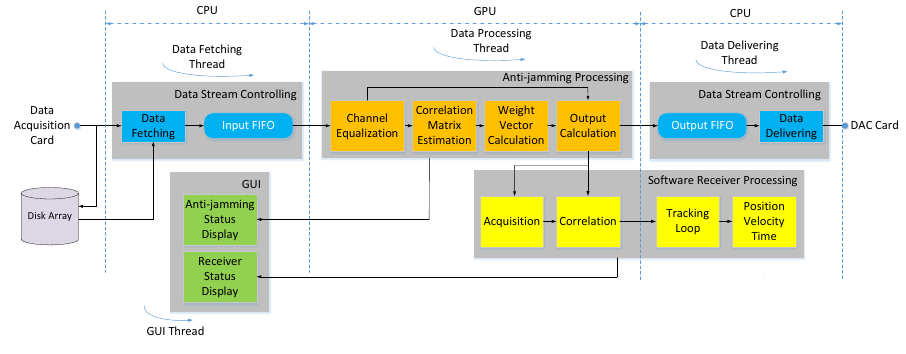
Figure 5. Software architecture.